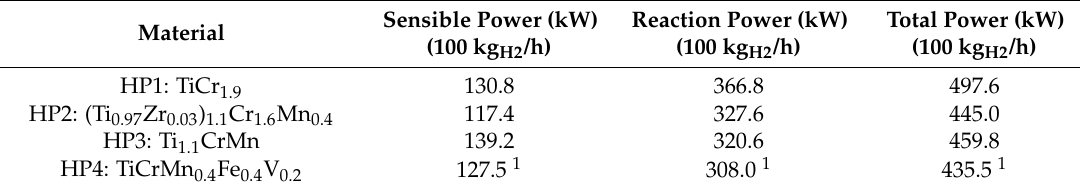
Table 3. Heating and cooling power duty of the four downselected high-pressure metal hydrides (HP1, HP2, HP3, and HP4) processing 100 kg/h.